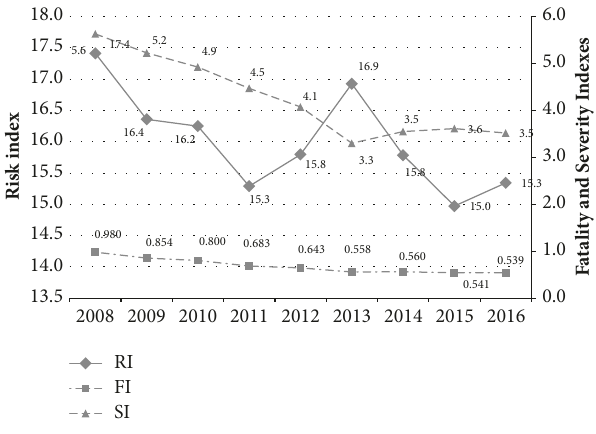
Figure 2: Evolution of the Road Safety